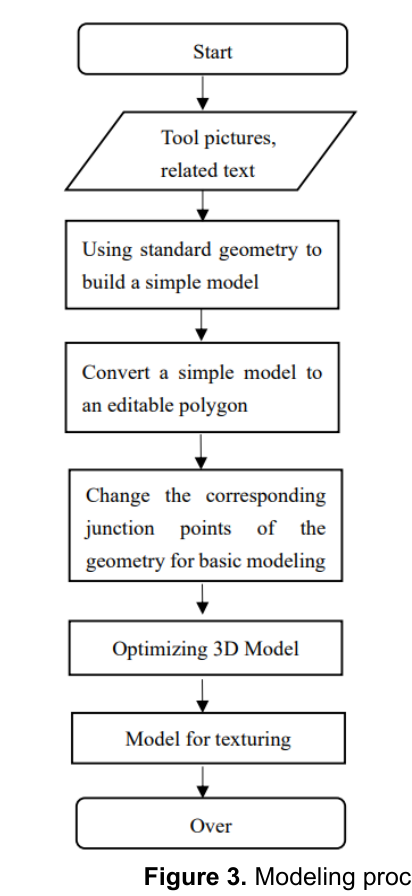
Figure 3. Modeling process